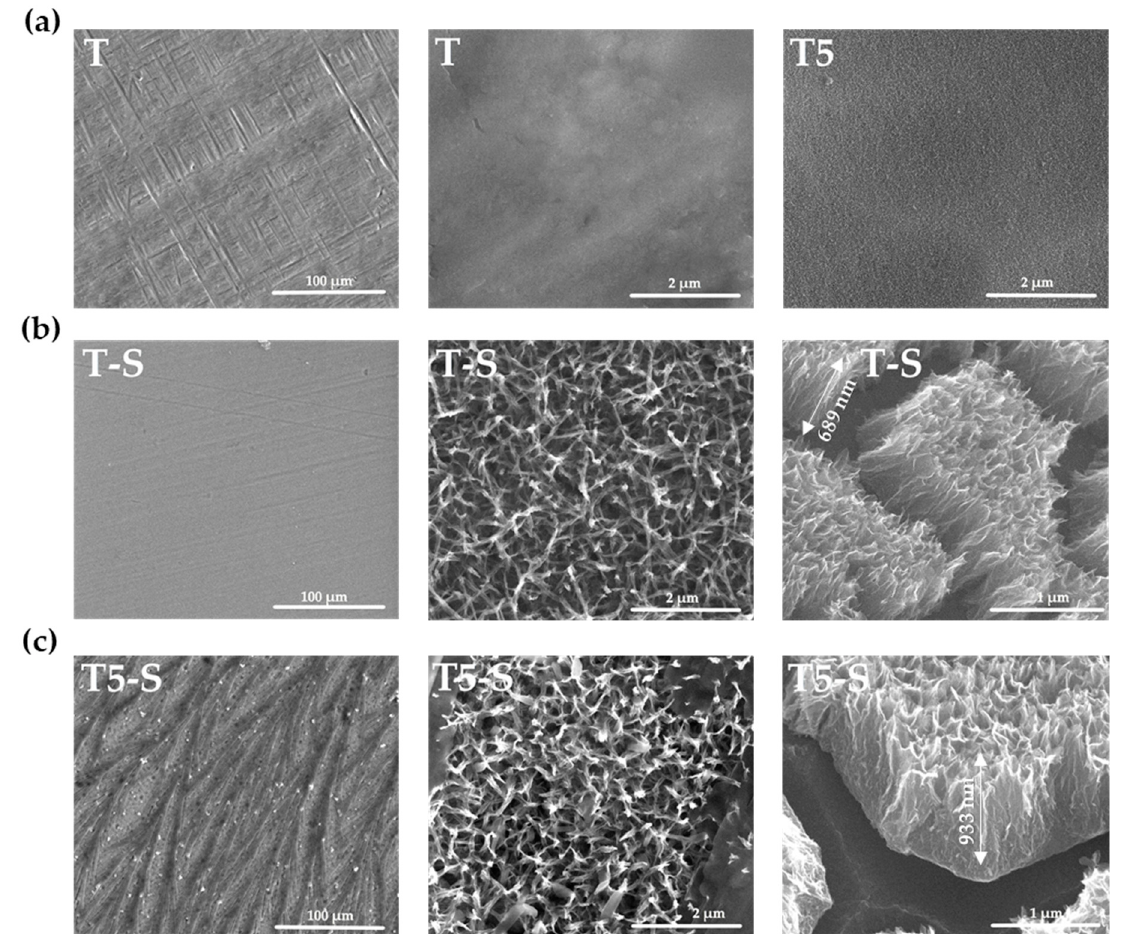
Figure 1. SEM images of the surface morphology and cross-sections of the T and T5 ( a ), T-S ( b ), and T5-S ( c ) samples. The use of scanning electron microscopy with energy-dispersive spectroscopy (SEM/EDS) method allowed confirming the presence of Na + on the surface of the samples after alkaline treatments (T-S and T5-S) (Figure